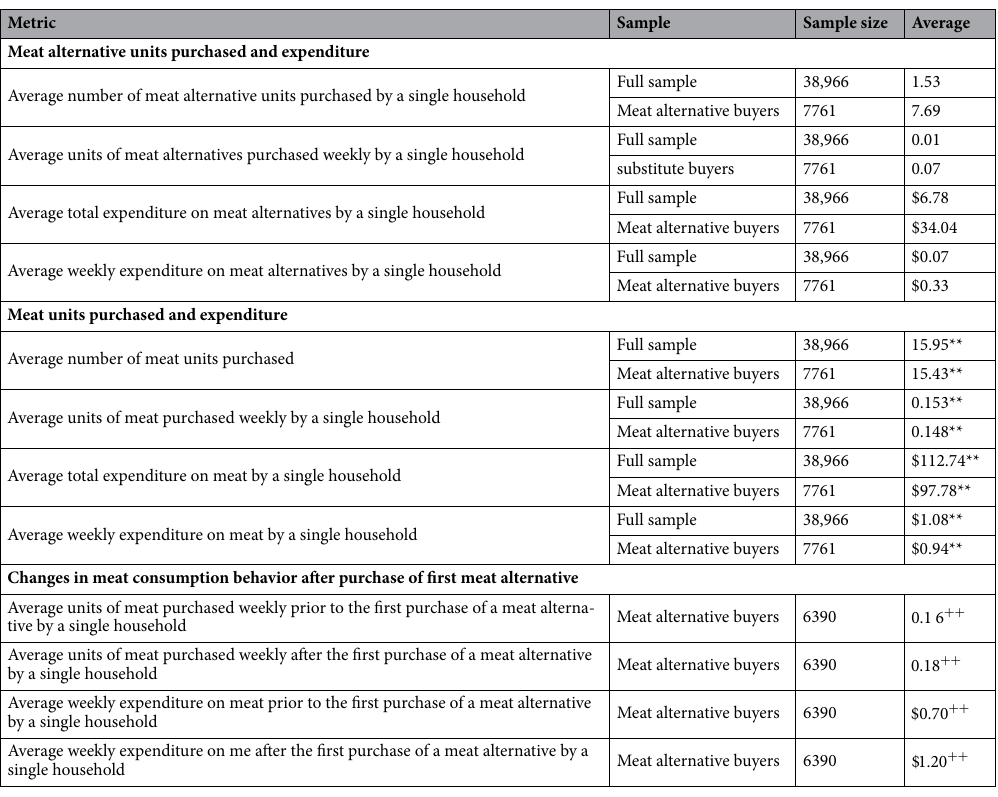
Table 2. Average Expenditures and Units Purchased. A *denotes an ANOVA test conducted to compare the means between the meat alternative buyers and remaining sample, with the null hypothesis µ Full = µ Buyer . A * denotes statistical significance at the 5% level and ** denotes significance at the 1% level. A + denotes a paired T-test to compare the difference in means of two different variables with the null hypothesis µ after − µ before . A + denotes significance at the 5% level and a + + denotes significance at the 1%